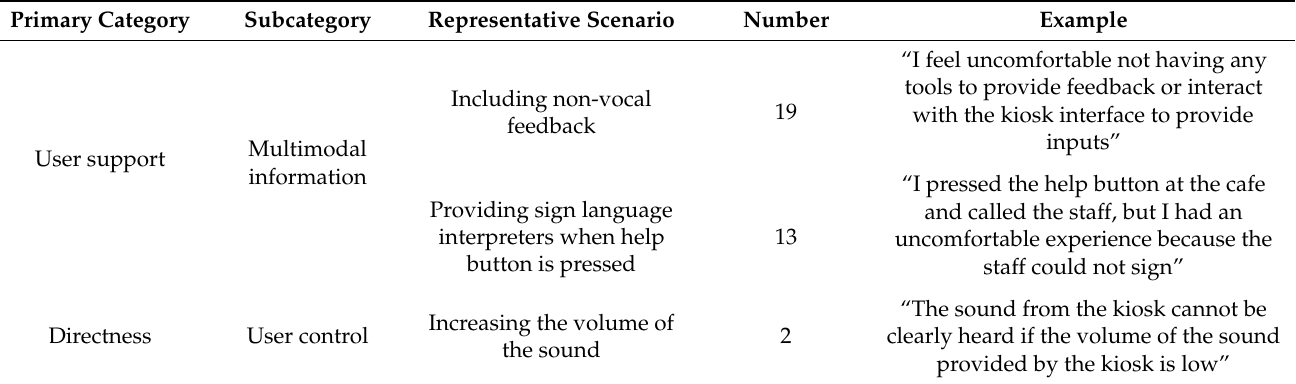
Table 4. Accessibility items for participants with hearing impairments.